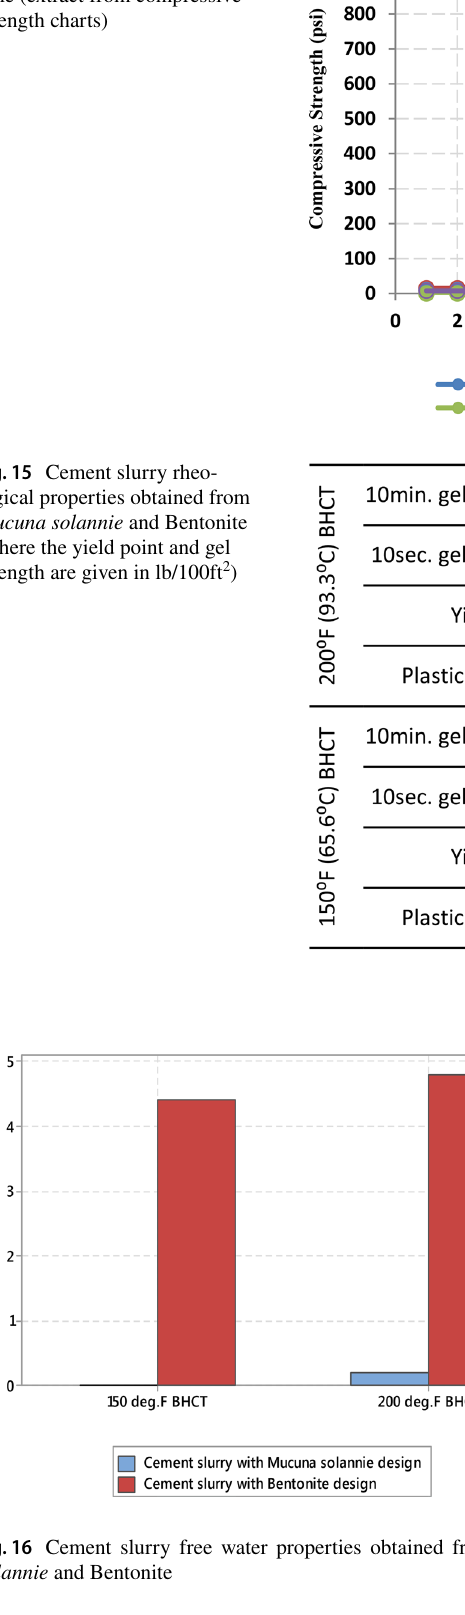
Fig. 14 Comparison of com- pressive strength trend with time (extract from compressive strength charts)